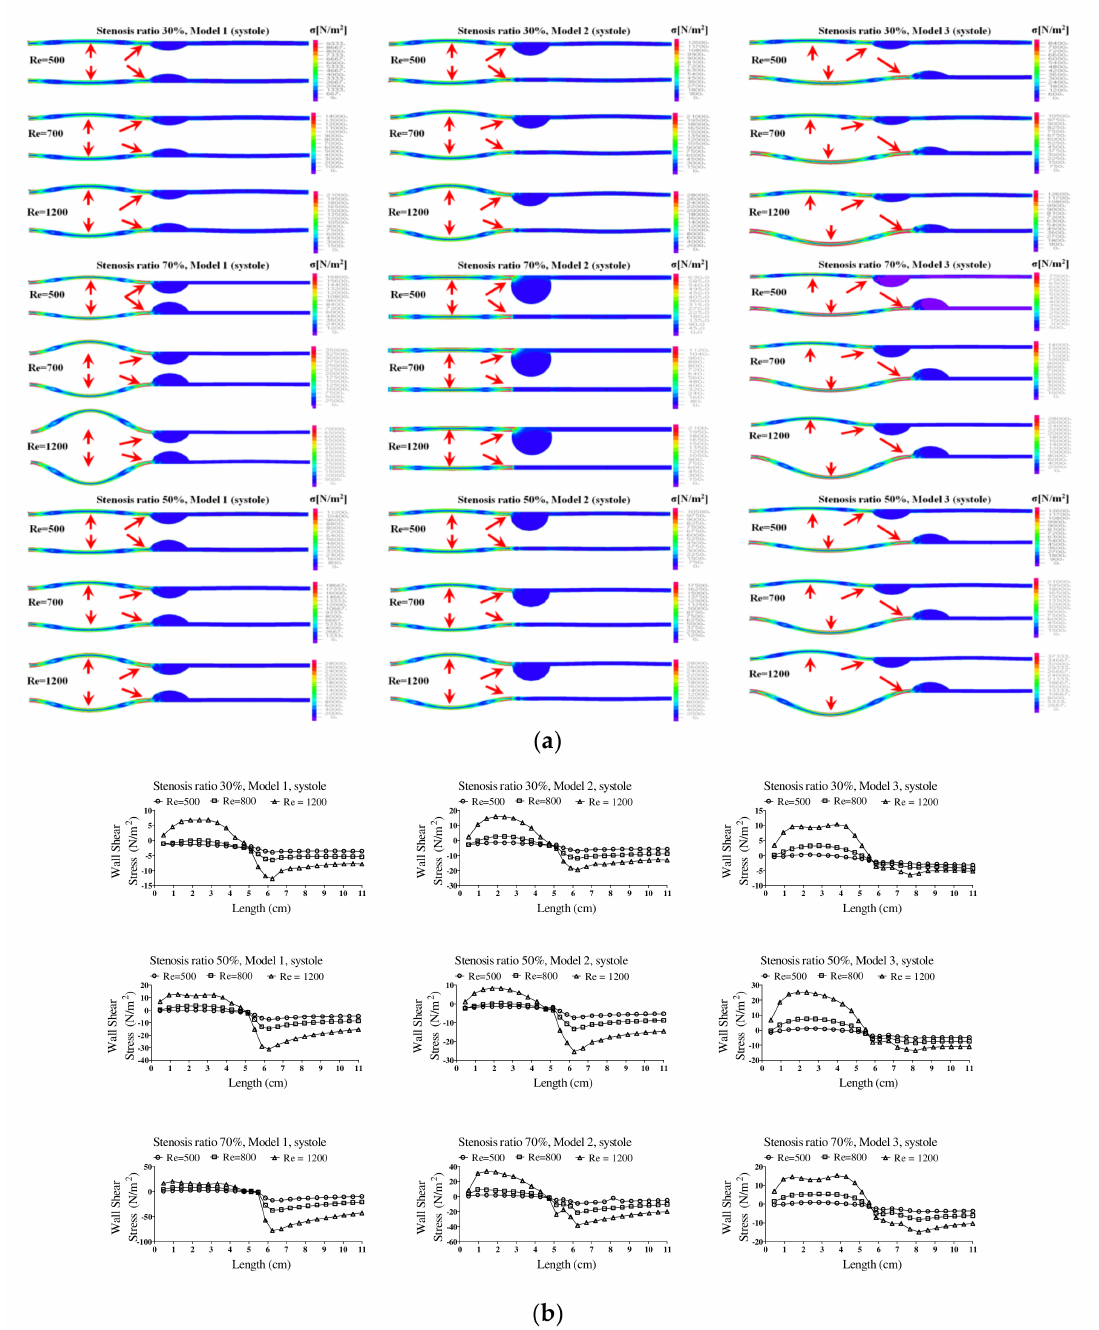
Figure 7. The wall load distribution and wall shear stress on the wall of blood vessels in the pulsatile flow. ( a ) Systolic wall load distribution, ( b ) systolic wall shear